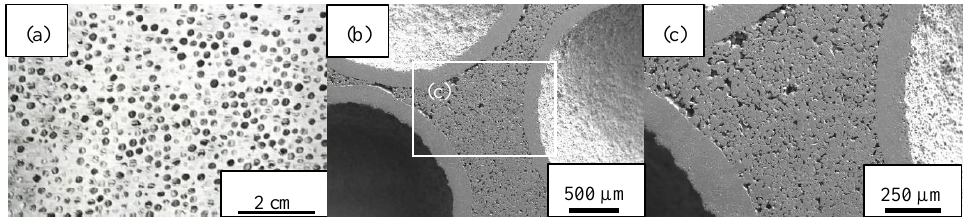
Figure 2. ( a ) Digital image showing a cut surface and structure of the SS-CMF plate. ( b , c ) SEM imaging of SS-CMF showing its general microstructure. The sectioned hollow metal spheres shown in ( b ) are surrounded by a metallic matrix and ( c ) shows a zoomed in image of the matrix region between the sphere walls, outlined by the white box in